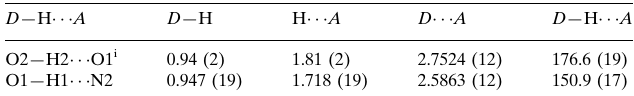
Hydrogen-bond geometry (A˚ , (cid:2)